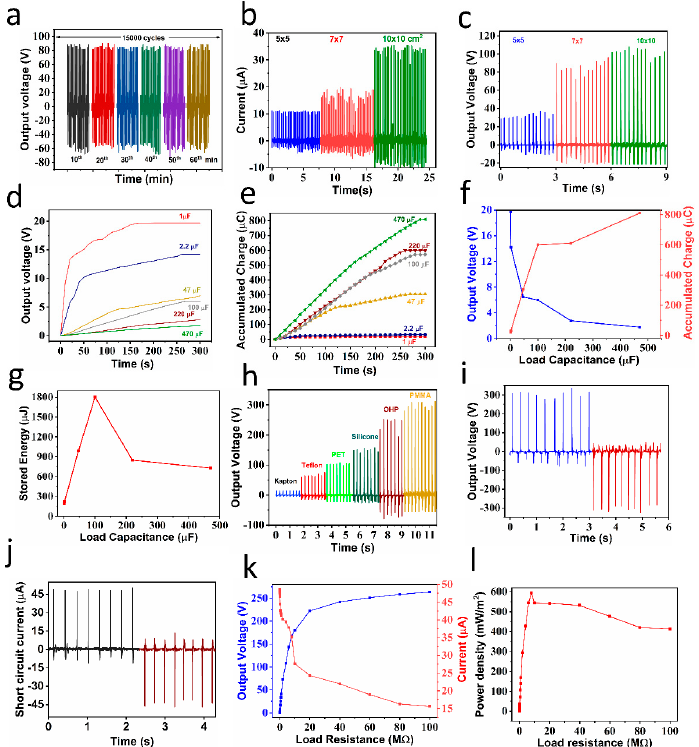
Figure 4. Stability of the TENG device (10 × 10 cm 2 ): ( a ) TENG electrical characteristics with different sizes of the frictional layer, ( b ) short-circuit current, ( c ) open-circuit voltage, ( d ) charging curves for different capacitors, ( e ) stored charge curves of different load capacitors as a function of time, ( f ) output voltage and stored charges behavior as a function of the load capacitance, ( g ) the maximum stored energy as a function of the load capacitance, ( h ) output voltage response of TENG device with different top triboelectric layers and ZIF-67 as the bottom triboelectric layer (Al/ZIF-67/PMMA/Al TENG device), ( i ) output voltage response, ( j ) output current response, ( k ) voltage and current response with load resistant variation, and ( l ) power density variation with different load resistance (all the measurements were recorded considering a device area of 10 × 10 cm 2 ).